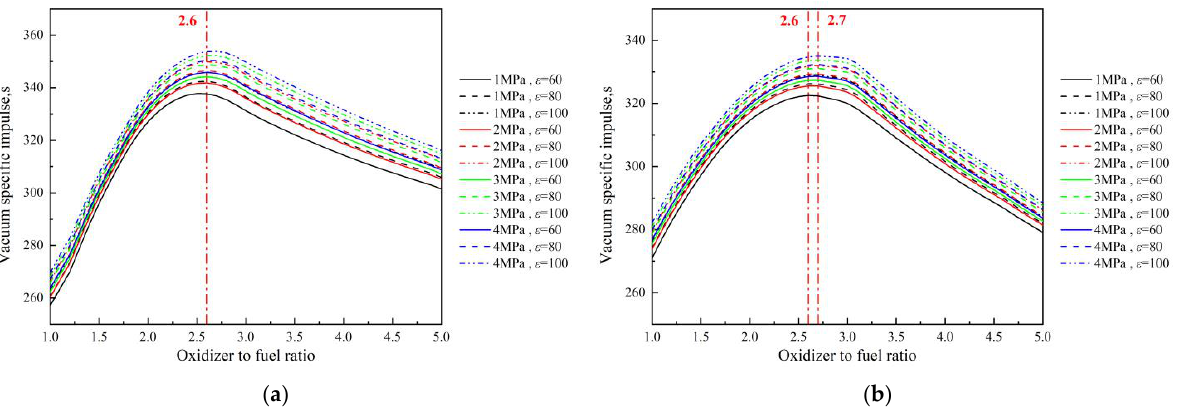
Figure 4. I svac - 𝛼 curves under different chamber pressure/nozzle expansion ratio. ( a ) liquid oxy- gen/kerosene; ( b ) N 2 O 4 /UDMH.